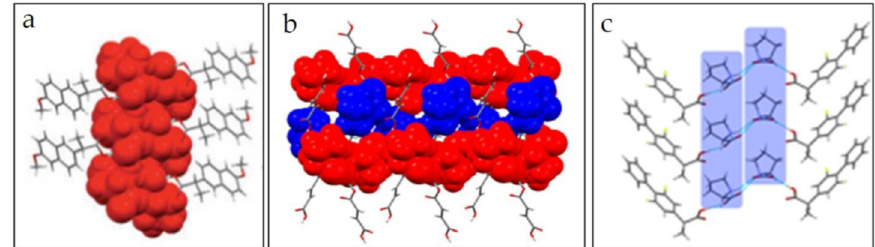
Figure 5. Single crystal structure of S-naproxen- L -proline co-crystal [87] ( a ), fumaric acid- L -proline co-crystal [21] ( b ), and RS-flurbiprofen- L -proline co-crystal [88] ( c ).